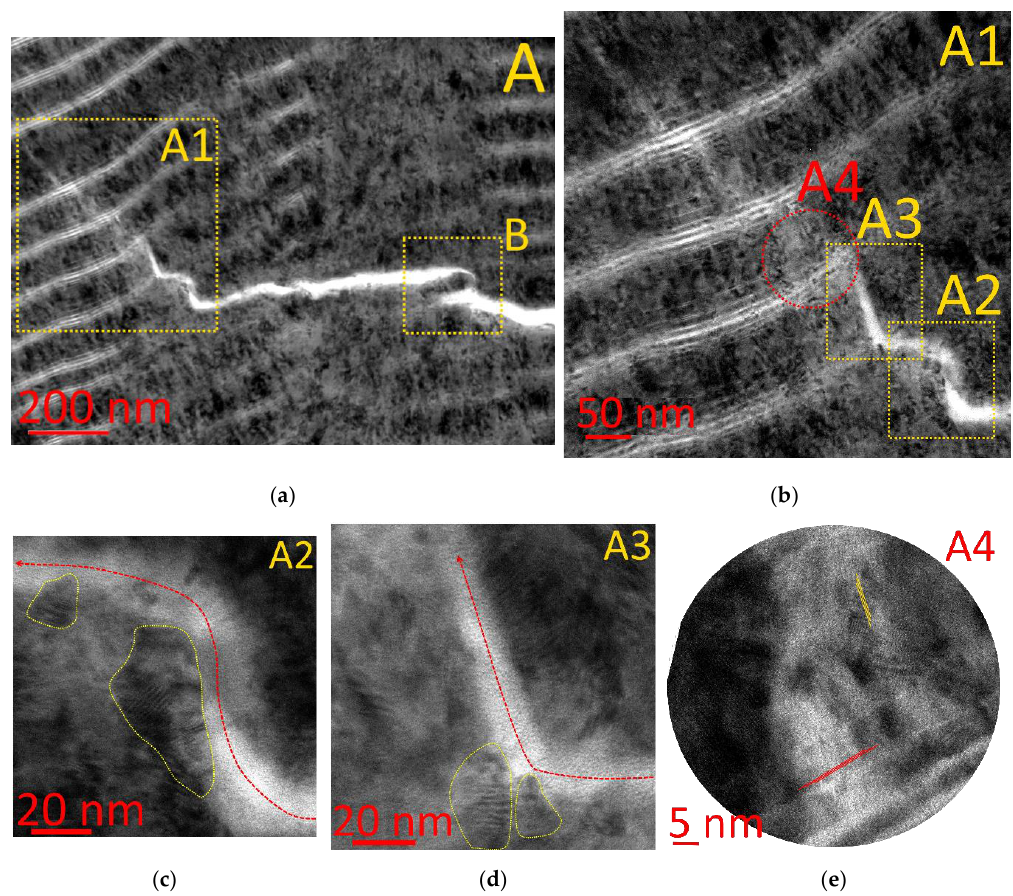
Figure 7. Pattern of crack propagation through the structure of the nanolayer coating. ( a ) general view of Area A, ( b ) General view of area A1—crack completion, ( c , d ) areas A2 and A3—fracture direction transformation, ( e ) Area A4—change in crystal structure during crack propagation.